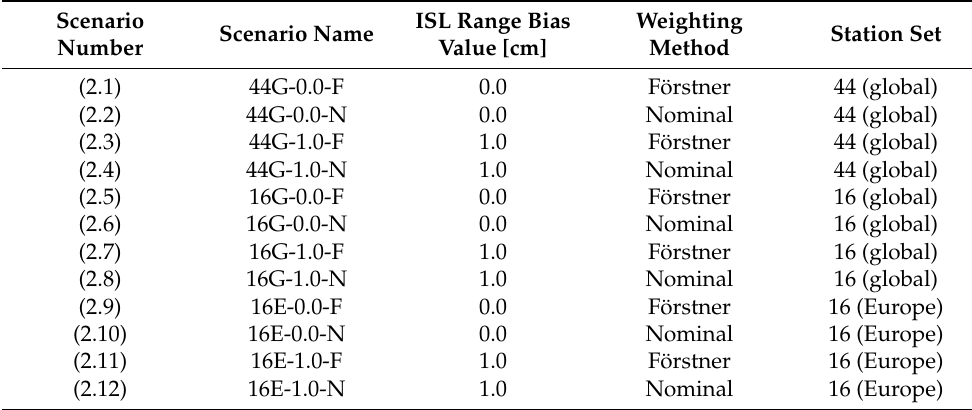
Table 5. Summary of simulation scenarios used for the ISL range bias estimation